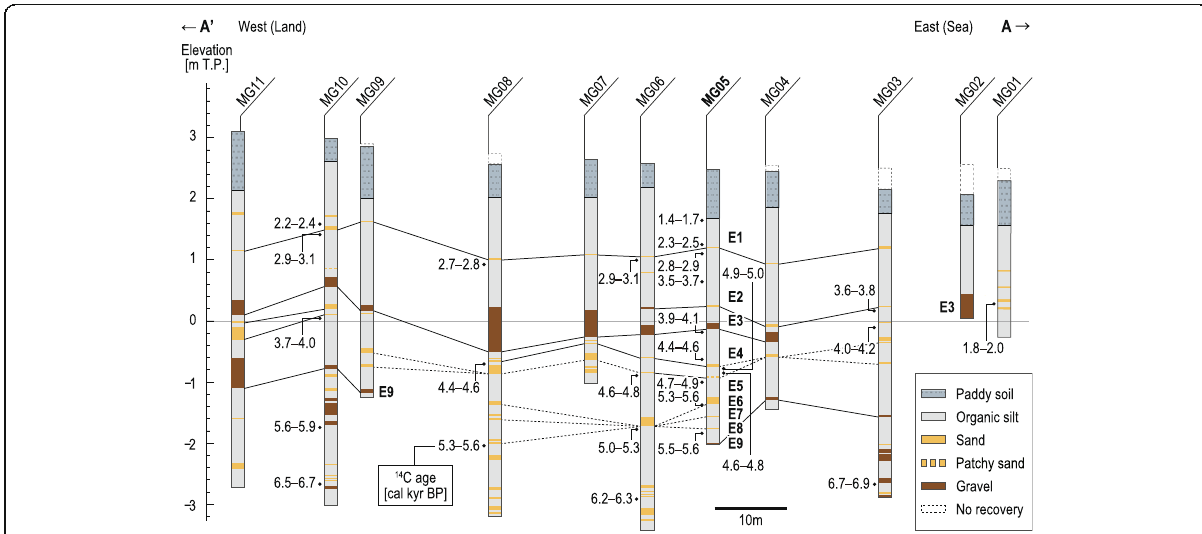
Fig. 2 Lithostratigraphy of the study site along transect A – A ′ in Fig. 1d. Radiocarbon ages are detailed in Table 2. The correlation of event deposits between core sites is shown by solid lines, with tentative correlations shown by dotted lines